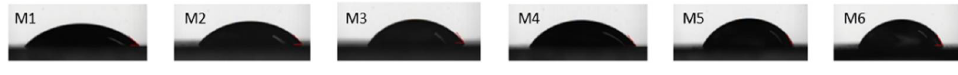
Figure 8. WCA of M1–M6 membranes. Table 2. Thickness and mechanical properties of PVDF-g-SSS membranes.